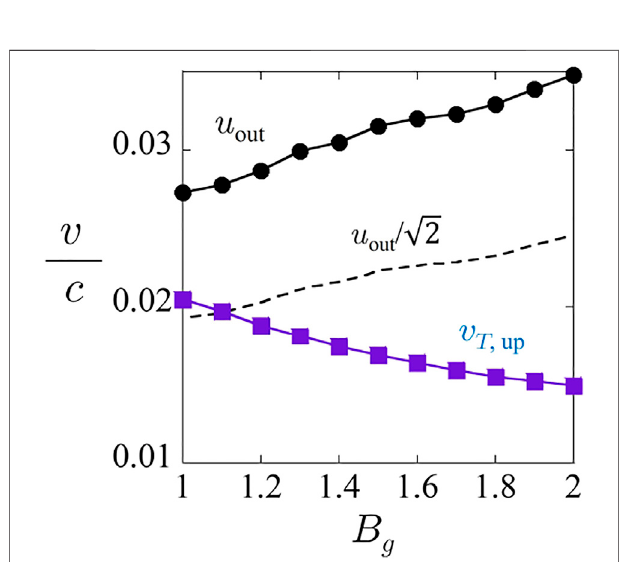
FIGURE 9 | Reconnection out fl ow velocity u out (the black solid line) and ion thermal velocity in the upstream v T ,up (the blue solid line) for various values of the guide fi eld ratio B g . For comparison, u out / is added.